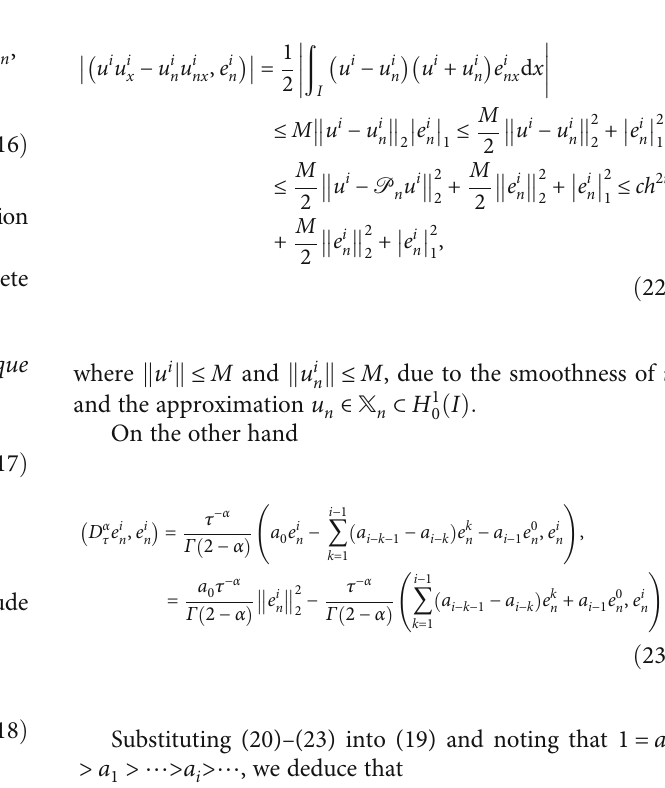
in (18), we have Table 1: Errors and convergent orders of MAM in temporal n